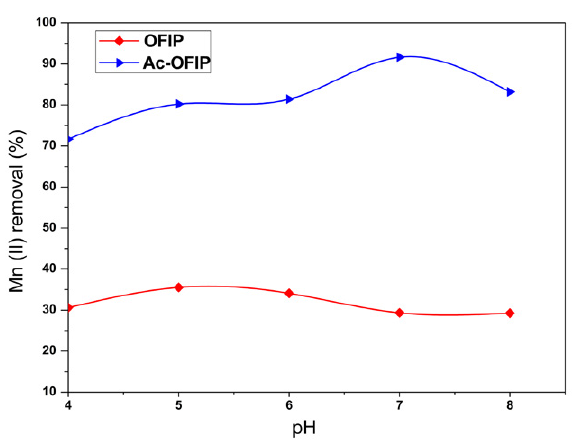
Fig. 3. Effect of pH on the adsorption of Mn (II) ions on OFIP and Ac-OFIP.